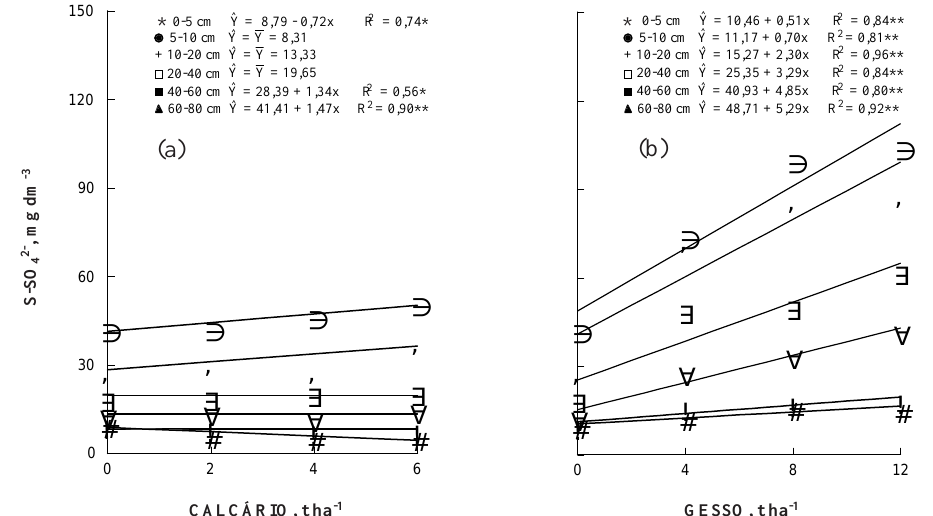
Figura 6. Efeito de doses de calcário, após 40 meses (a), e de gesso, após 36 meses (b), sobre os teores de 2- , em diferentes profundidades. *, ** significativos a 5 e 1%, S-SO 4